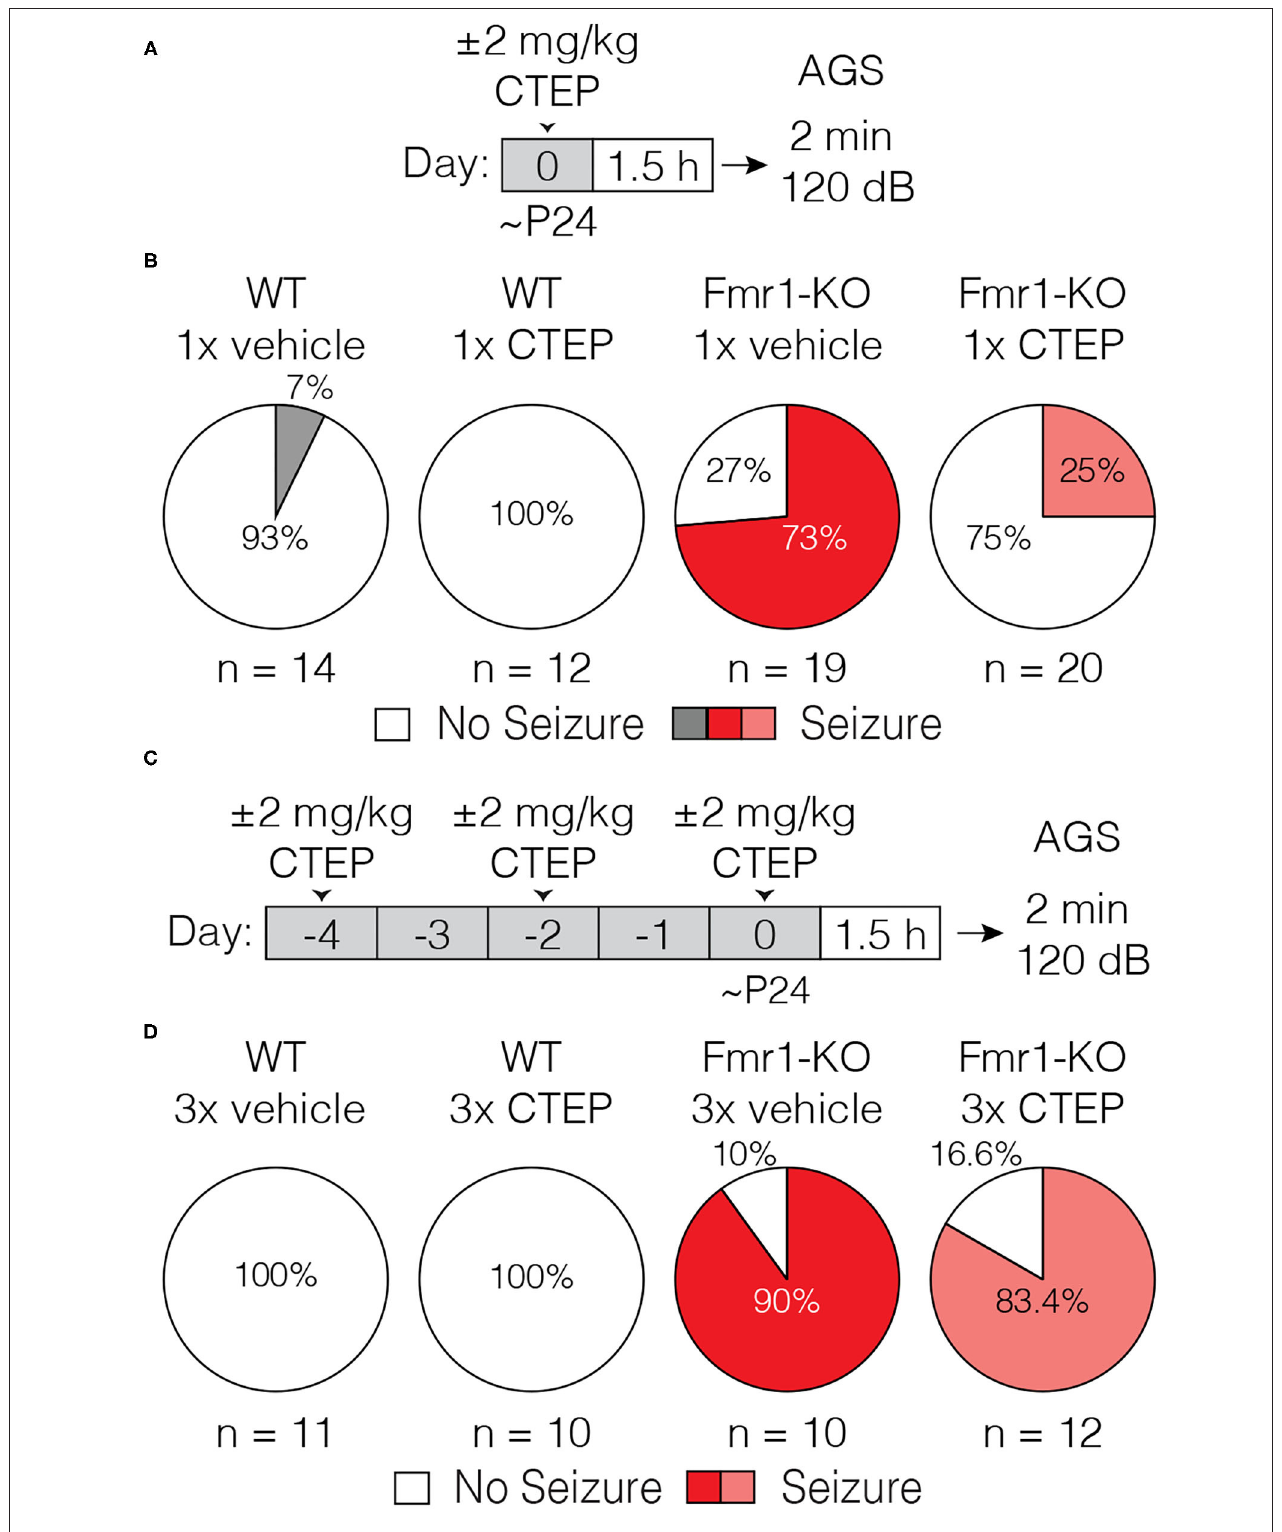
FIGURE 1 | Acute but not chronic administration of the mGluR5 NAM CTEP ameliorates audiogenic seizures in Fmr1-KO mice. (A) Schematic shows acute CTEP dose schedule and AGS experimental design. (B) Fmr1-KO mice treated with vehicle exhibit increased susceptibility to audiogenic seizures compared to WT treated with vehicle (two-tailed Fisher’s exact test: p = 0.0001) and an acute dose of 2 mg/kg CTEP significantly reduced AGS incidence in Fmr1-KO mice (two-tailed Fisher’s